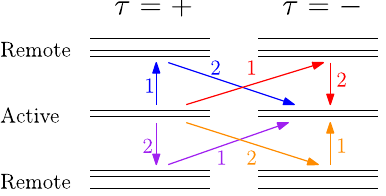
FIG. 8. Virtual processes in second-order perturbation theory which hop an electron from valley τ ¼ þ to valley τ ¼ − due to quenched random bond